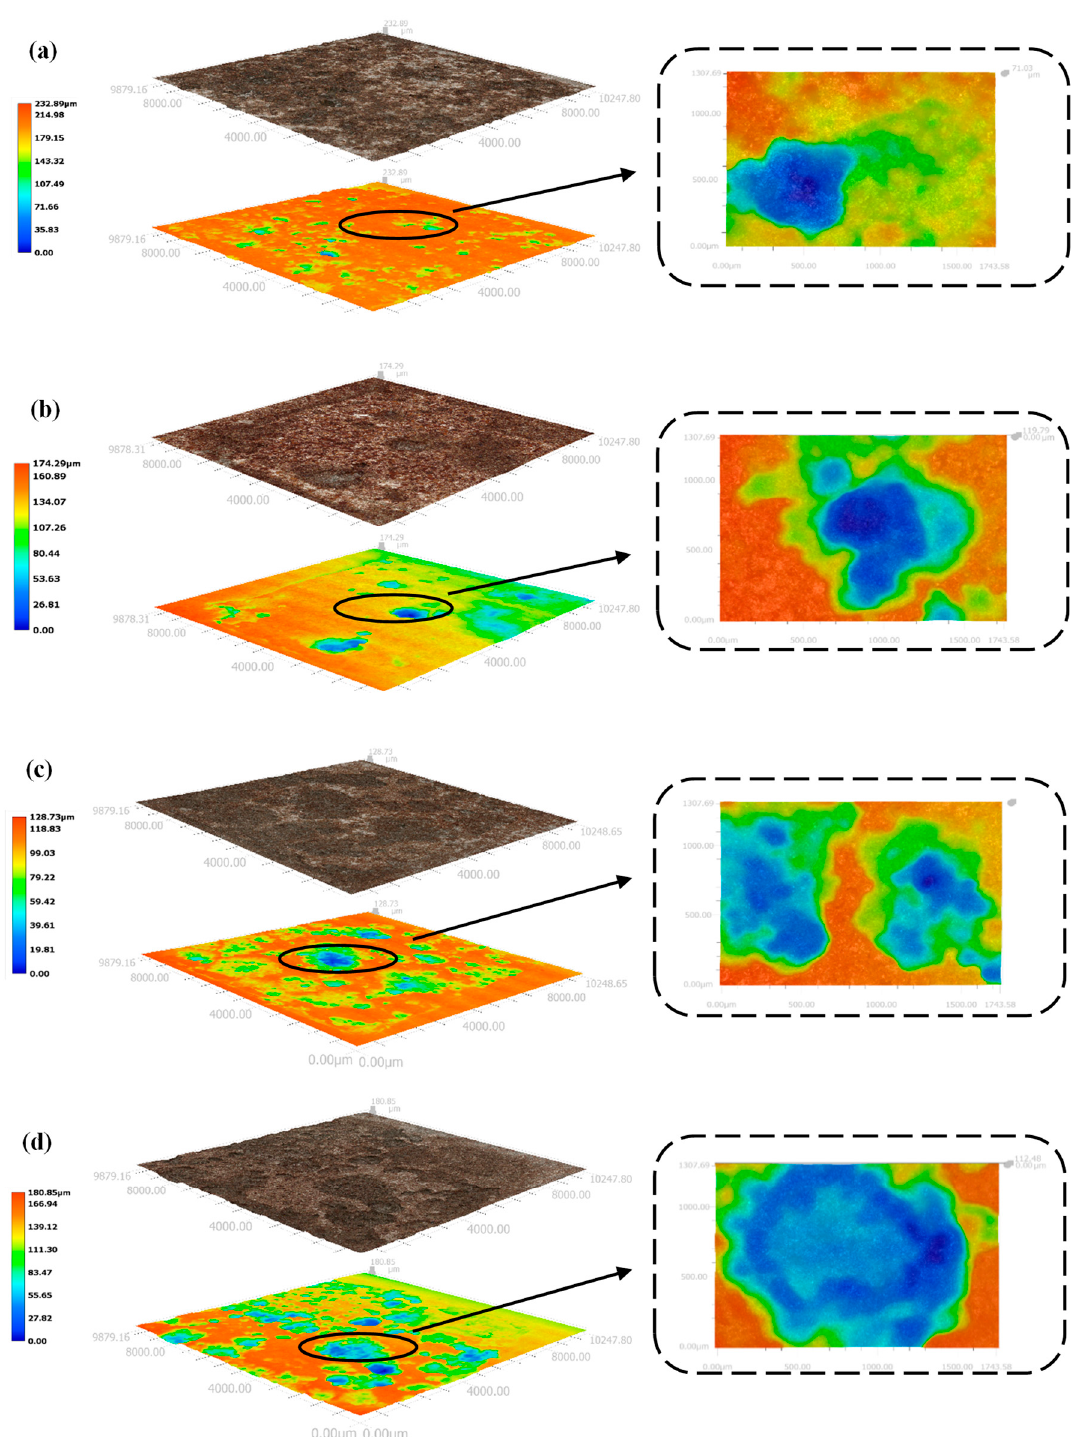
Figure 17. Macroscopic and microscopic corrosion morphology and elemental analysis results of X70 steel under capillary action in saline soils with a NaCl content of 0.3%: ( a ) 12 # , ( b ) 27 # , ( c ) 42 # , and ( d ) 57 # .